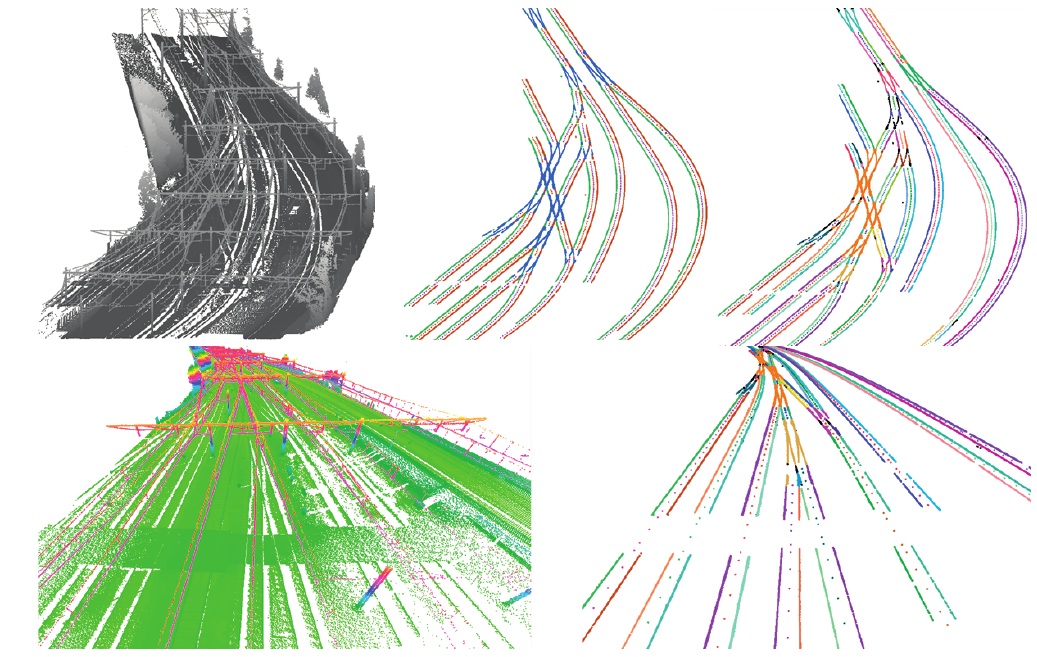
Figure 9. Rail track detection and centerline extraction from Sittard area. Top and bottom left: original point cloud; top center: points labelled by left/right rail piece, center points and switches; top and bottom right: points colored by connected component, center points derived at intervals of 2 m.